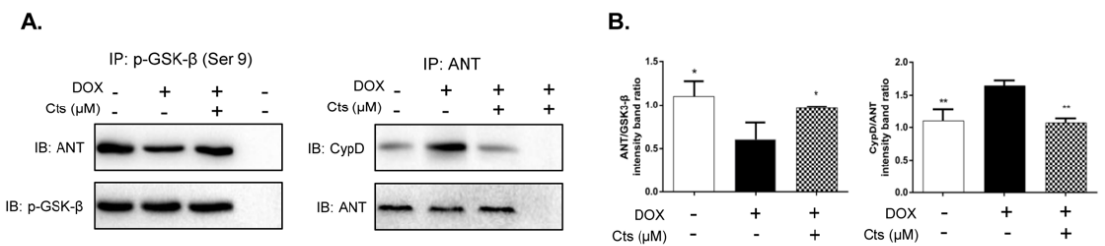
Figure 5. Effects of Cts on the binding of p-GSK-3 β (Ser9) to ANT and the formation of the ANT-CypD complex. ( A ) Immunoprecipitation assay showed that Dox stimulation decreased binding of p-GSK-3 β to ANT, whereas Cts treatment increased p-GSK-3 β -ANT interaction. ( B ) Immunoprecipitation assay showed that formation of the CypD-ANT complex was activated by Dox-stimulation. Cts treatment inhibited interaction of CypD and ANT. Results were presented as means ± SD from independent experiments performed in triplicate. * p < 0.05, ** p < 0.01 vs. Dox-treatment group.